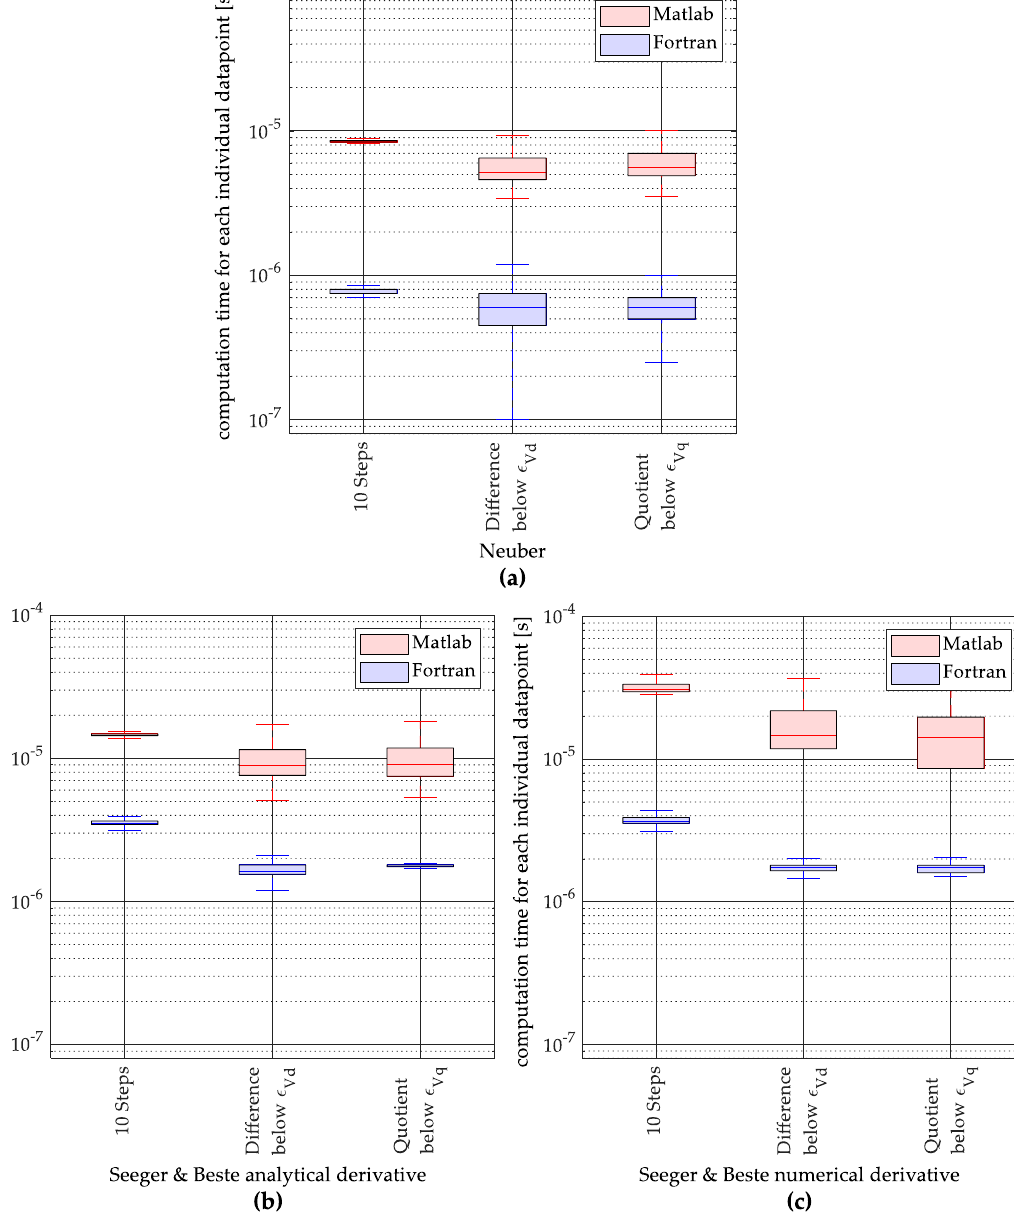
Figure 7. Calculation time of the various Newton termination criteria when using the extended notch root approximation according to Neuber ( a ), according to Seeger and Beste using the analytical derivative ( b ) and according to Seeger and Beste using the numerical approximation of the derivative ( c ).